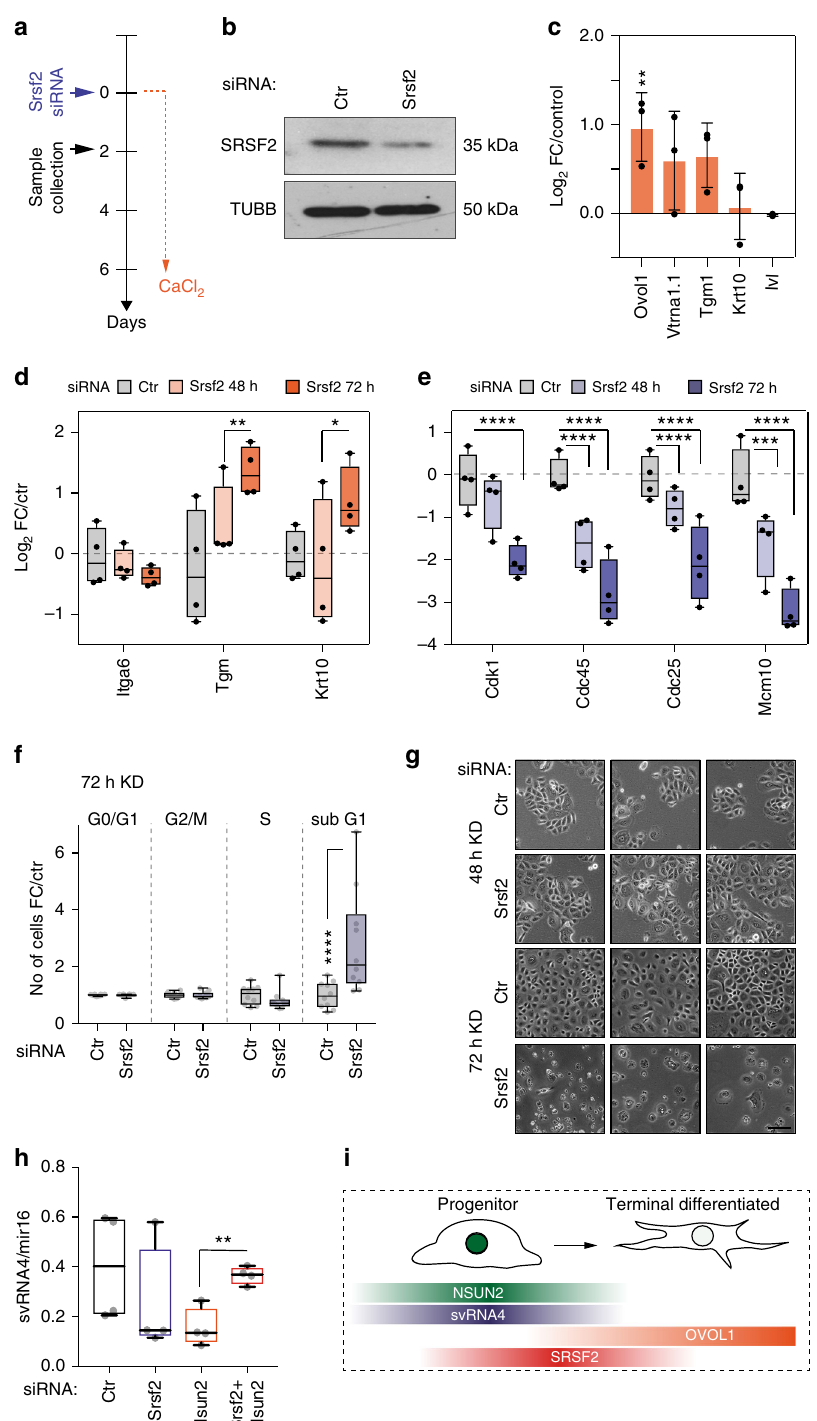
Fig. 5 SRSF2 is required for cell cycle and survival of undifferentiated cells. a Treatment regime and transfection of differentiating primary human keratinocytes. b Western blot detecting SRSF2 after treatment with Srsf2 siRNA. Tubulin (TUBB) serves as loading control. c Quanti fi cation of RNA expression levels of Ovol1, Vtrna1.1, Tgm , Krt10 , and Ivl after 6 days of calcium-induced differentiation vs. untreated control (0 days). FC: Fold-change. Error bars indicate s.d. ( n = 3 qRT-PCRs). ** p < 0.01 two-way ANOVA. d , e Log 2 RNA fold-change (FC) of differentiation markers ( d ) and cell cycle regulators ( e ) after 48 and 72 h of Srsf2 knock-down. Data shown as box plot with mean showing all data from minimum to maximum ( n = 4). **** p < 0.0001, *** p < 0.001, ** p < 0.01, * p < 0.05 Two-way ANOVA. f Cell cycle distribution of primary HK transfected with the Srsf2 siRNA for 72 h. Error bars Data shown as box plot showing all data from minimum to maximum ( n = 10 Flow sorts). **** p < 0.0001 Two-way ANOVA. g Light microscope images of HK transfected with a control (ctr) siRNA (upper panels) and a Srsf2 siRNA (lower panels) after 48 and 72 h in low calcium medium. Scale bar: 50 μ m. h Small RNA qRT- PCR measuring the abundance of svRNA4 in primary HK transfected with the indicated siRNA constructs. Data shown as box plot with mean showing all data from minimum to maximum. Error bars represent s.d. ( n = 4 qRT-PCRs). ** p < 0.01 unpaired student ’ s t -test. i Illustration how levels of NSUN2, svRNA4, SRSF2, and OVOL1 change upon terminal differentiation in keratinocytes. Source data are provided as a Source Data fi